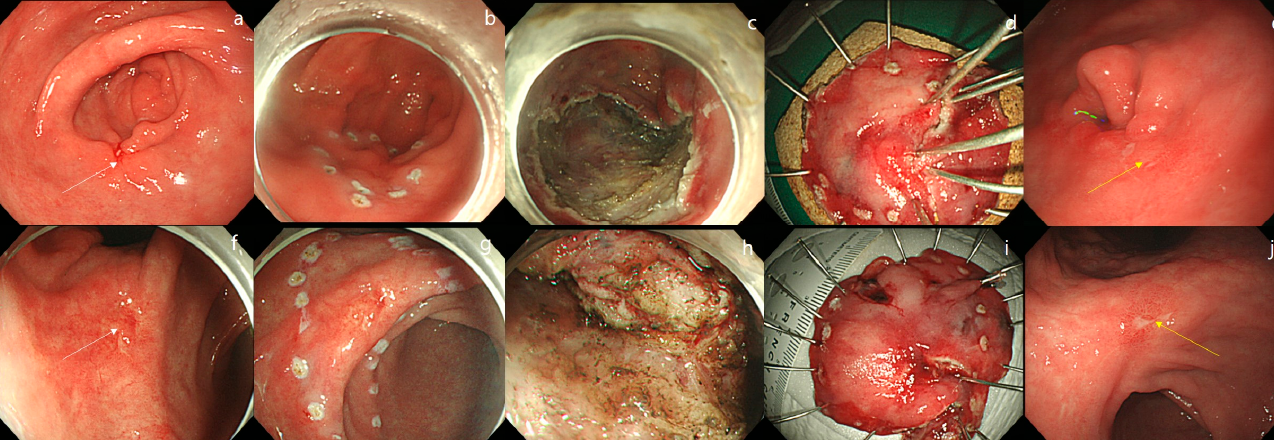
Figure 3. Endoscopic findings of early gastric cancer (EGC) with local recurrence. ( a ) Local recurrence at the proximal margin of the artificial ulcer scar. ( b , c ) A 20-mm sized, well-differentiated EGC lesion with ulceration was resected using the endoscopic submucosal dissection (ESD) method. ( d ) Although the artificial ulcer was clear, the lesion was resected in two pieces. Pathologic examination revealed mucosal cancer without lymphatic invasion and negative lateral margin. ( e ) After 8 years, an 18-mm sized, well-differentiated EGC lesion is observed. ( f ) Local recurrence at the center of the artificial ulcer scar. ( g ) A 22-mm sized, well-differentiated EGC lesion is observed with a sus- picious ulcer scar deformity. ( h ) Extensive submucosal fibrosis is observed. ( i ) ESD was performed en-bloc. ( j ) After two years, a 20-mm sized, recurrent EGC lesion with ulceration is observed.